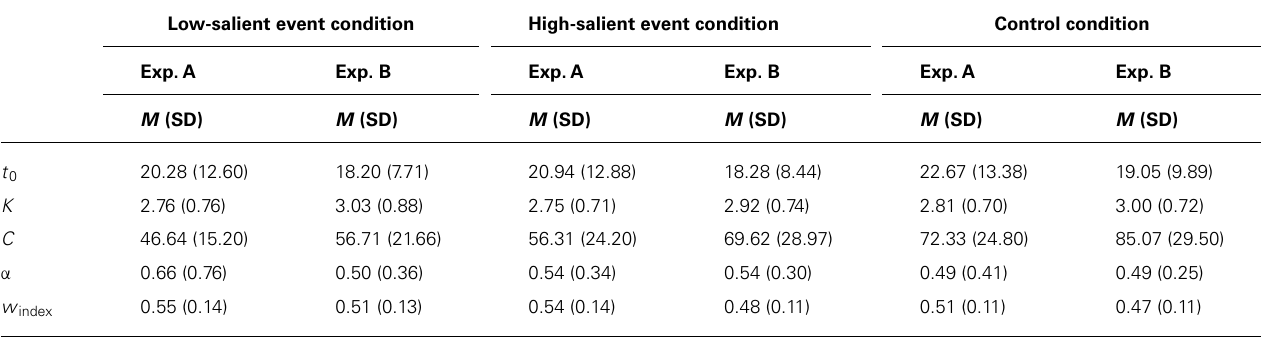
Table 1 | Descriptive statistics of attentional components.